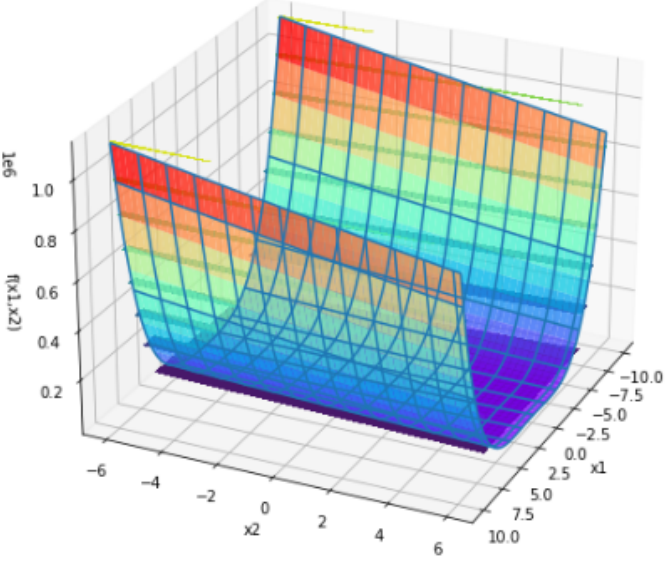
Figure 1. Surface plot of Rosenbrock